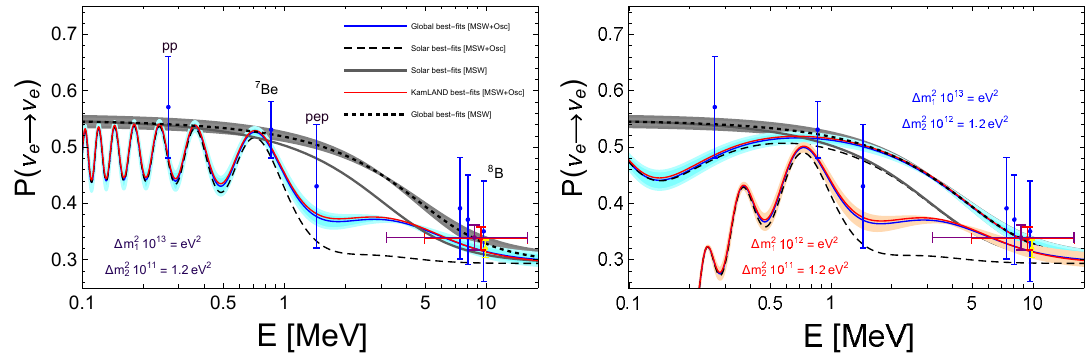
Figure 3 . Solar ν e survival probability as a function of neutrino energy, where N e ’ 85 . 5 N A cm − 3 in eq. (4.8) at around the center of the Sun is used. The points represent, from left to right, the Borexino pp , 7 Be, pep , and 8 B data (blue points) given in [84] and the SNO+SK 8 B data (yellow point) given in [1]. Also shown are the SNO+SK data (red point) and SNO LETA + Borexino (purple point) of the 8 B flux [18]. The error bars represent the 1 σ experimental + theoretical uncertainties. The gray shaded band corresponds to the prediction of the MSW-LMA solution of the 3 ν SF using the 1 σ parameter values given in table-1 and the black dotted line for the best-fits, while the gray line corresponds to the solar best-fits of eq. (2.17). In left plot for new predictions of the MSW+ Oscillation effects for ∆ m 2 = 10 − 13 eV 2 and ∆ m 2 = 1 . 2 × 10 − 11 eV 2 , the cyan band 1 2 corresponds to the 1 σ parameter values in table-1 and the blue solid line for the global best-fits, while the red solid line corresponds to the KamLAND best-fits of eq. (2.17) and the black dashed line for the solar best-fits of eq. (2.17). In right plot, the cyan band (blue solid, red solid, and black dashed lines) correspond to ∆ m 2 = 10 − 13 eV 2 and ∆ m 2 = 1 . 2 × 10 − 12 eV 2 , while the orange band 1 2 (blue solid, red solid, and black dashed lines) for ∆ m 2 = 10 − 12 eV 2 and ∆ m 2 = 1 . 2 × 10 − 11 eV 2 1 2